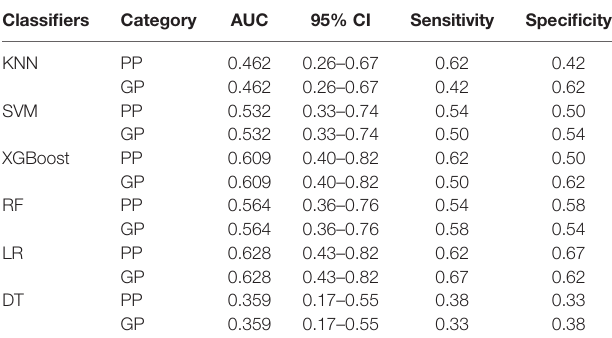
TABLE 5 | ROC s with six classi fi ers of validation set in delayed